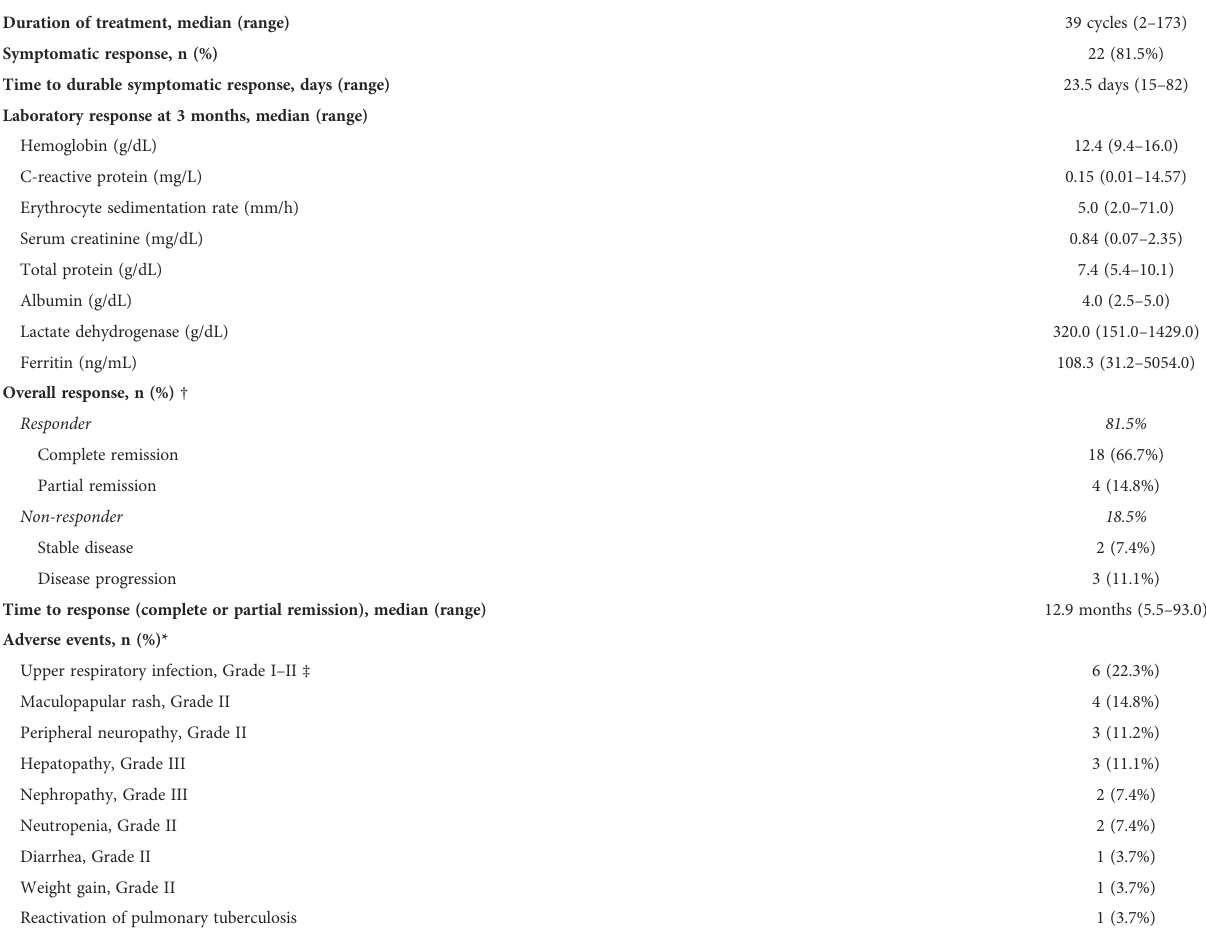
TABLE 3 Clinical responses of siltuximab-treated patients with MCD (n=27). Clinical